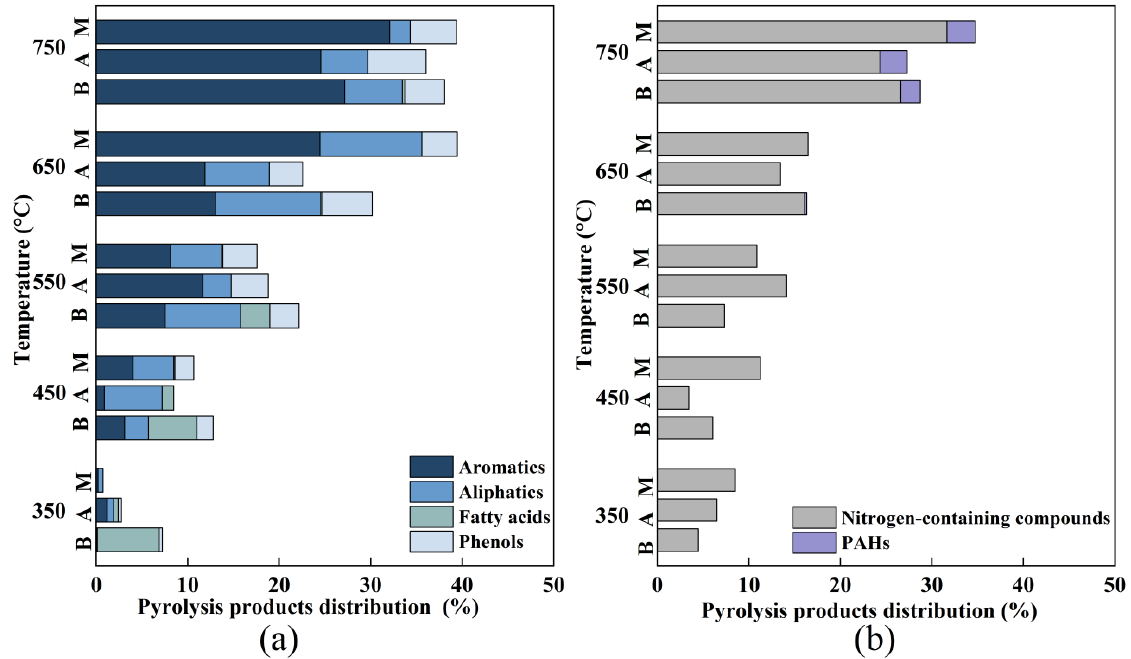
Figure 5. In the pyrolysis of microalgal leftovers grown on BG11, AW and MAW media; ( a ) useful chemicals, and ( b ) hazardous compounds were produced (A: AW; B: BG11; M: MAW). The numerical results are shown in Table A4 (Appendix D).